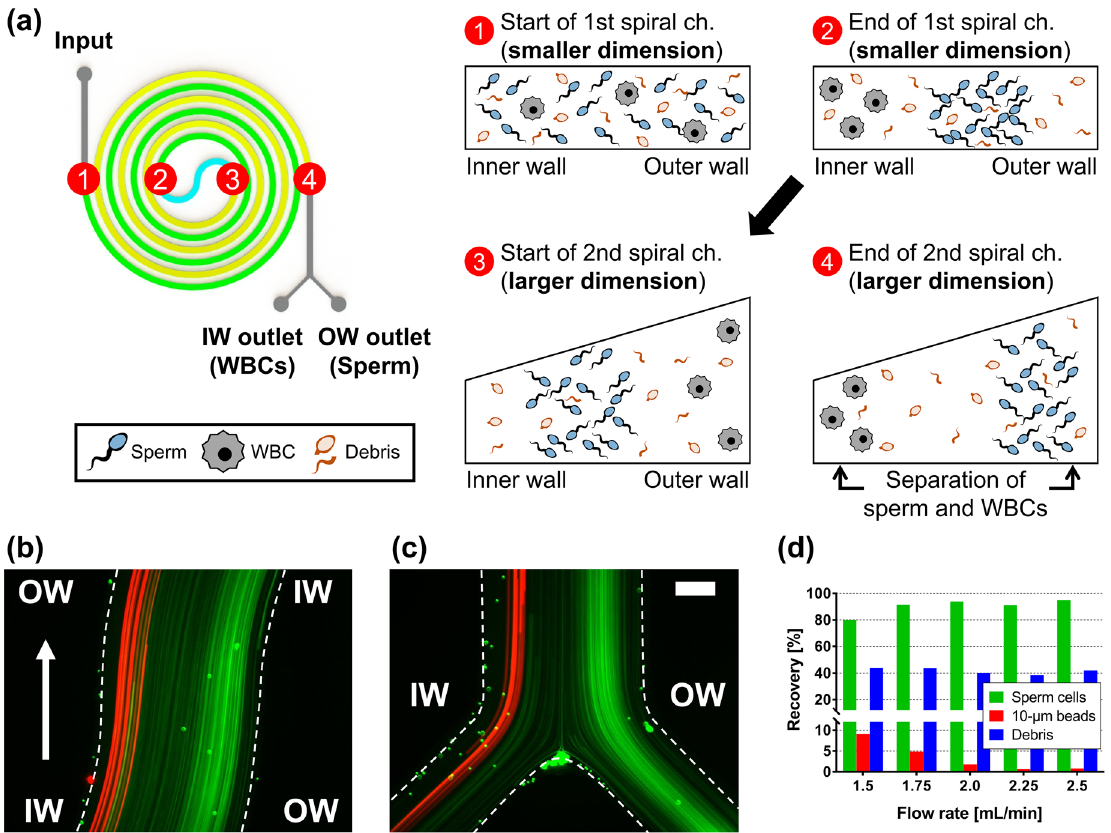
Figure 1. Overview of the semen preparation process by the MDDS device. ( a ) Channel configuration (green: the first spiral channel with smaller dimension, yellow: the second spiral channel with larger trapezoidal dimension) and schematic diagram of the operation process; the first spiral channel has a rectangular cross- section with 800 μm in width and 60 μm in height, and the second spiral channel was designed to have trapezoidal cross-section for the effective particle separation with 800 μm in width and 80 and 120 μm in height for the inner wall side and the outer wall side, respectively. Trajectories of DAPI-stained sperm cells (represented in green color for better recognition) and 10-μm red-fluorescence beads (mimicking leukocytes, represented in red color) at ( b ) the S-shaped transition region and ( c ) the bifurcation region of the MDDS device under the optimal flow rate condition, 2.0 mL/min (scale bar: 200 μm). ( d ) Recoveries of sperm cells, 10-μm beads, and debris from the outer wall outlet depending on various input flow rate conditions. IW, inner wall; OW, outer wall; WBC, white blood cell or